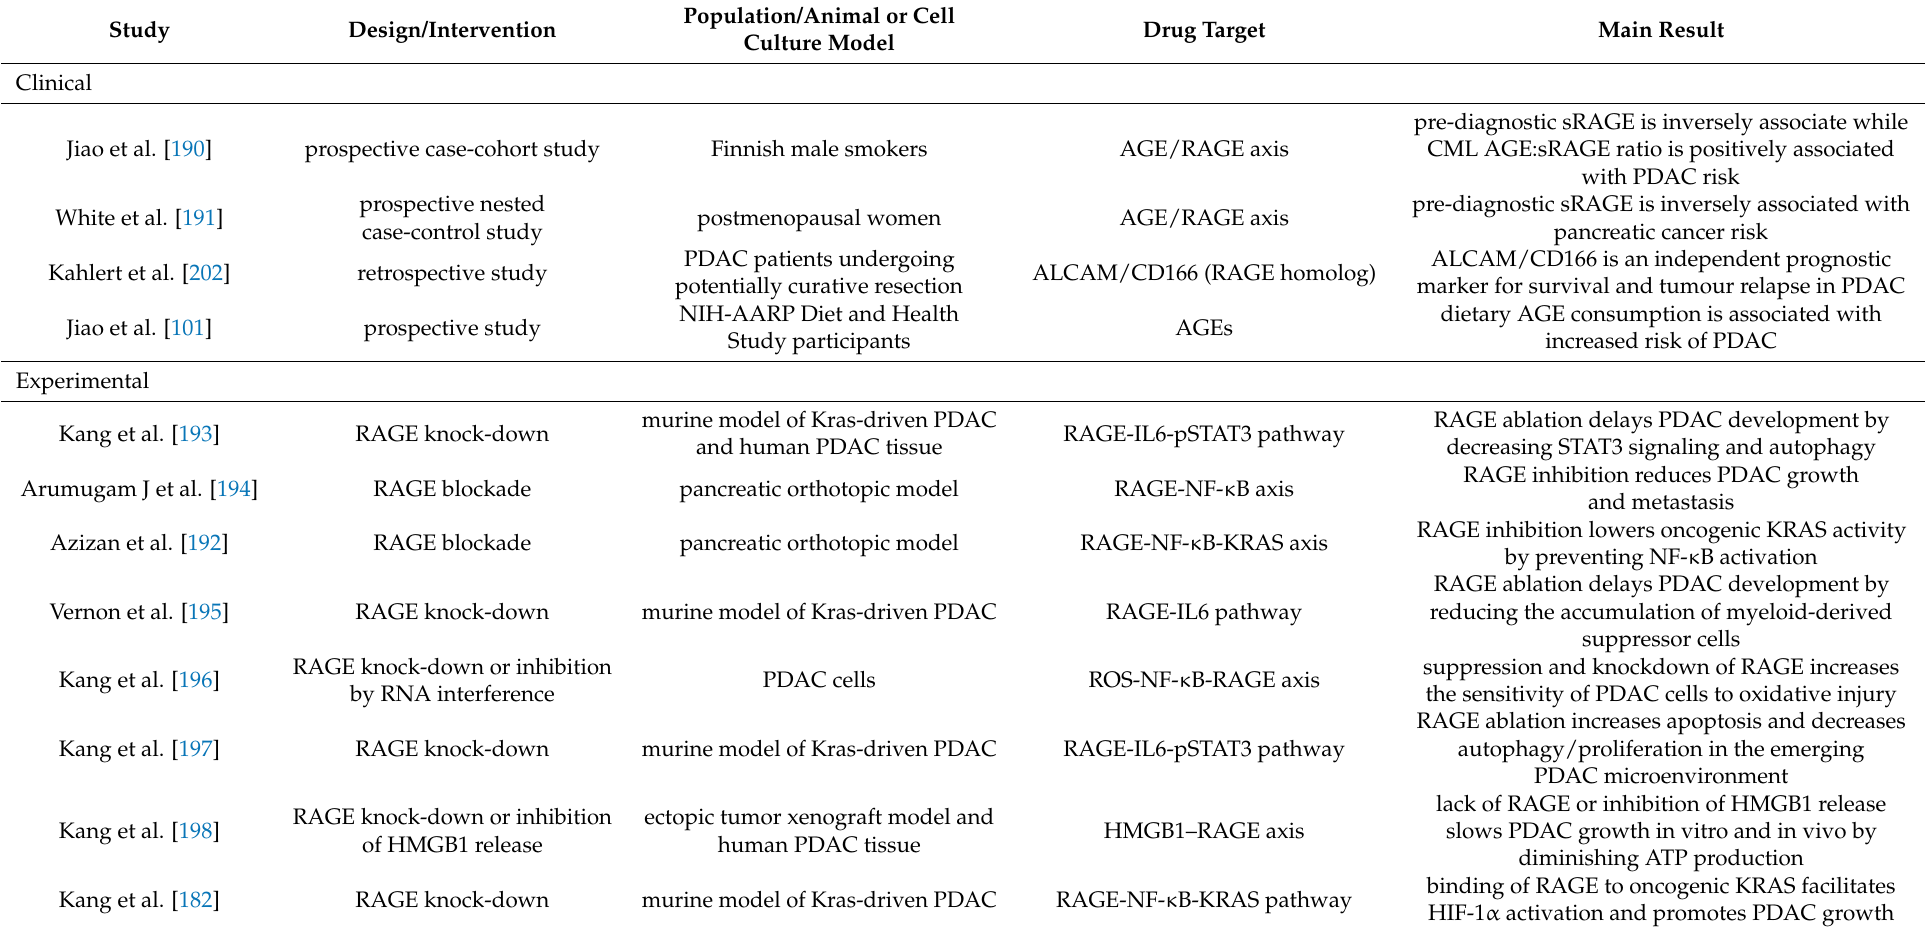
Table 1. Clinical and experimental studies on potential drug targets related to carbonyl stress in pancreatic ductal adenocarcinoma